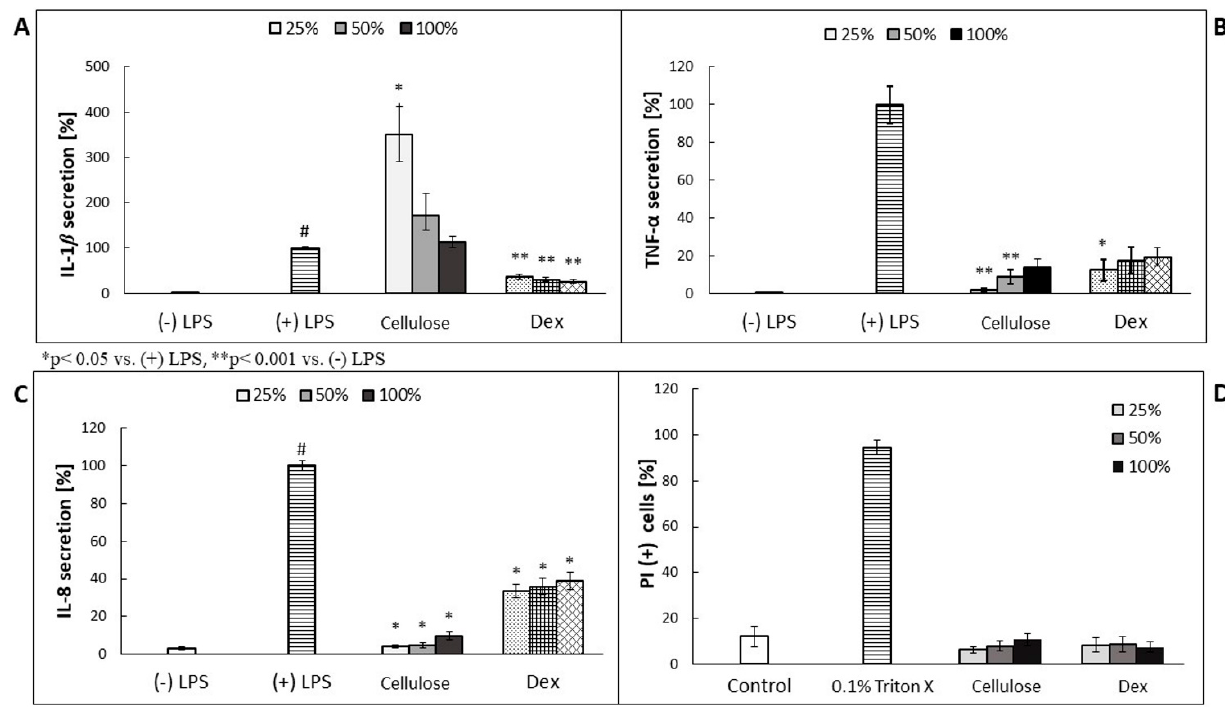
Figure 3. ( A – C ): The effect of 3-day-old NC cellulose containing C. majus cells on neutrophil IL-1 β , TNF- α and IL-8 release by LPS—stimulated (100 ng/mL) cells ((+) LPS). Dex—dexamethasone at concentrations of 0.25, 0.5 and 1.0 µM; ( D ): The cytotoxic effect of 3-day-old NC cellulose containing C. majus cells (after four weeks of culture) on neutrophils expressed as a percentage of PI (+) cells; Control, (+) LPS; cellulose = 3-day-old NC cellulose containing C. majus cells (after four weeks of culture) The data are expressed as the mean ± SE from three donors assayed in triplicate. Statistical significance of the cellulose versus the stimulated control at p ˂ 0.001 vs. (-) LPS is marked by ** ( A , B ), vs. (+) LPS by * ( C ), and vs. (-) LPS by # ( C ); at p ˂ 0.005 vs. (+) LPS is marked by * ( A , B ) (Mann–Whitney’s U-test). Table 3. Minimal Antimicrobial Concentration and Minimal Biofilm Eradication Concentration of liquid obtained from NBC